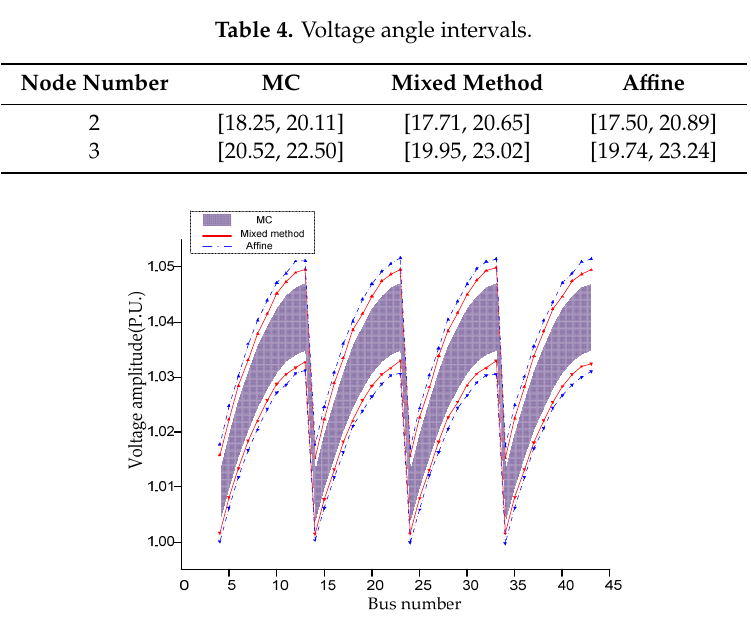
Figure 5. The voltage amplitude intervals of the PV power generation unit.